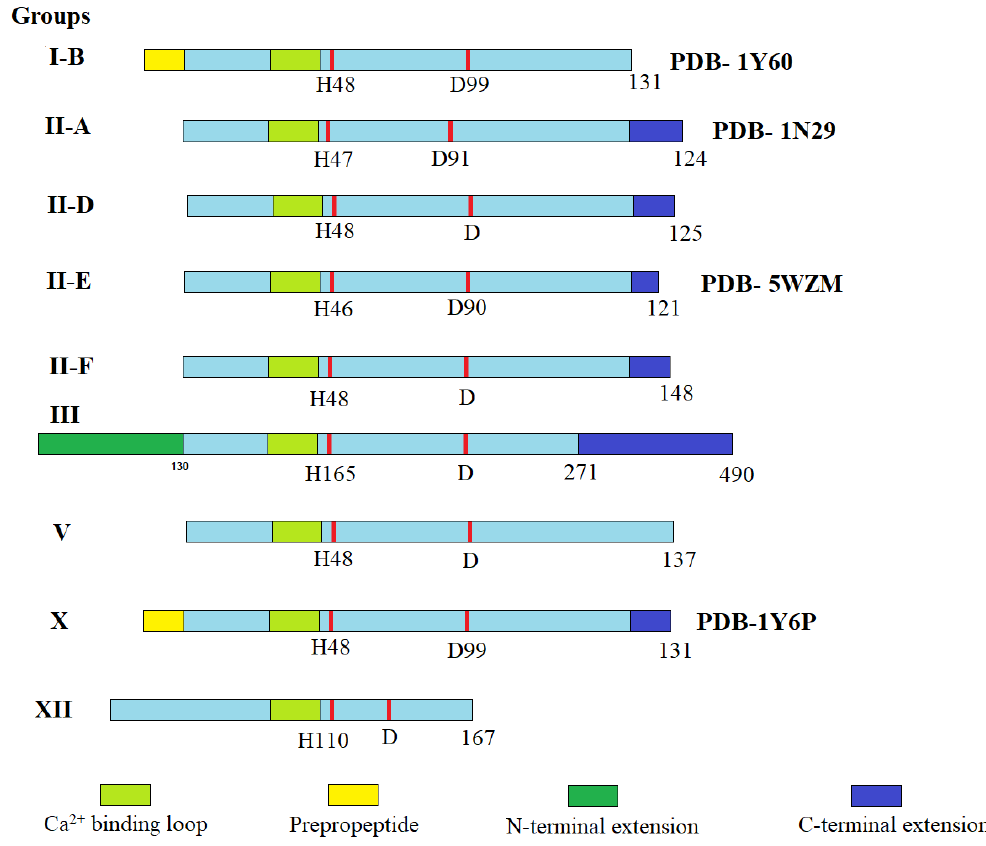
Figure 2. Schematic presentation of the different groups of secreted PLA2s found in humans (adapted from [6]). The Ca 2+ -binding loop is shown in light green, the key active site residues (His and Asp) are shown as red bars, and N-terminal (deep green) and C- terminal (deep blue) extension residues are also highlighted. Adapted with permission from [6]. Copyright 2011, American Chemical Society.